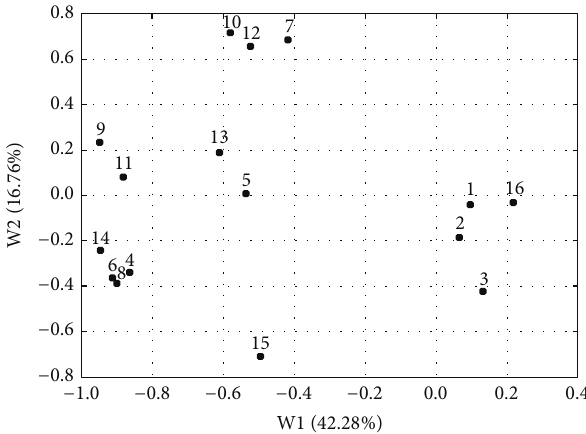
Figure 2: PCA scores plot illustrating the grouping of ninety-seven patients under antidepressant therapy. I : cluster Ia, e : cluster Ib, ◻ : cluster II, and ◼ : cluster III.